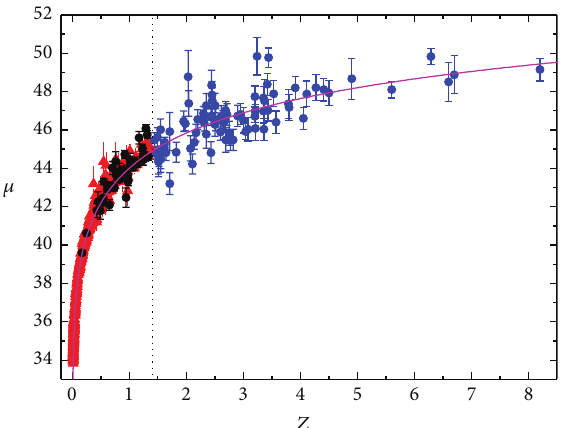
Figure 2: Hubble diagram of 580 SNIa (red triangles) and 139 GRBs (dots) obtained using the interpolation method. The 57 GRBs at 𝑧 ≤ 1.4 are obtained by interpolating from SNe Ia data (black dots); and the 82 GRBs at 𝑧 > 1.4 (blue dots) are obtained with the five correlations calibrated with the sample at 𝑧 ≤ 1.4 using the cubic spline interpolation method. The vertical dotted line represents 𝑧 = 1.4 . The solid curve represents the best-fit cosmology for a flat = 0.29 , Ω = 0.71 Λ CDM universe: Ω 𝑚 Λ